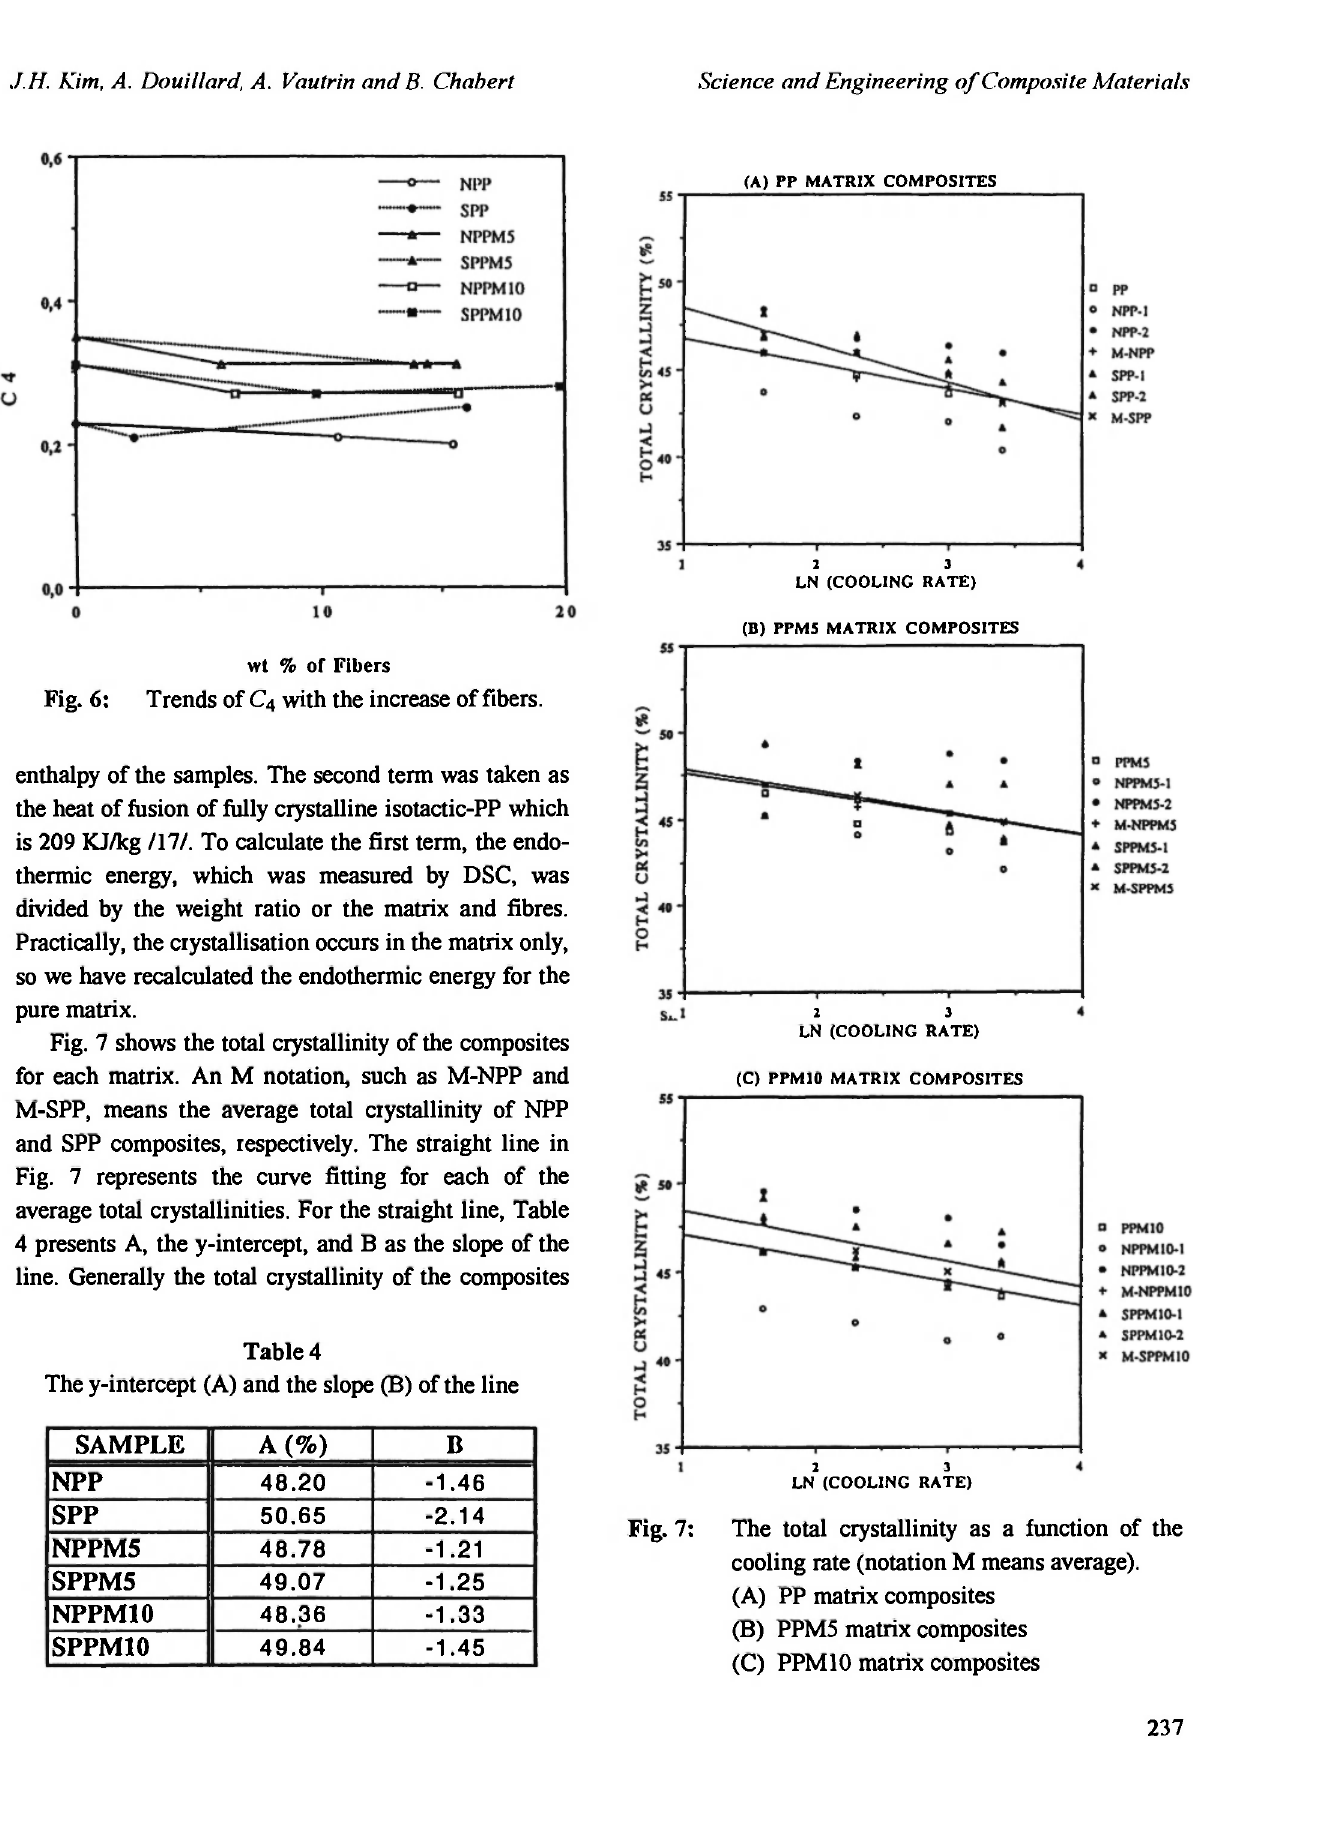
Fig. 7: The total crystallinity as a function of the cooling rate (notation Μ means